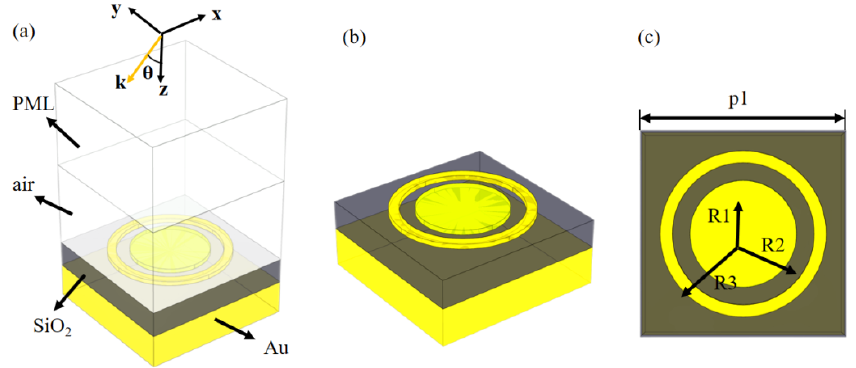
Figure 1. ( a ) Front view of absorber, ( b ) periodic unit of absorber, ( c ) top view of absorber. We implement the periodic array with a single structural unit by setting Floquet periodic boundary conditions. When the electromagnetic wave is incident perpendicular to the absorber surface, the electric and magnetic fields are parallel to the x and y axis directions respectively. The z-direction is set to perfectly match the layer, as shown in Figure 1a. In the simulation, all the metallic layers are composed of gold material. In the closed-loop disc structure and geometrical parameters we designed, the electromagnetic resonance of a specific frequency occurs when the electromagnetic wave interacts with ω 2 p the absorber. By means of the Drude model [35–37] ε = 1 − . We can calculate the ω ( iwt ) dielectric constant of gold, where the volume plasma frequency is ω p = 1.37 16 s − 1 and collision frequency ω t = 1.23 14 s − 1 [38]. When the thickness of the underlying metal is greater than the maximum skin depth of the metal in terahertz, spectrum the transmittance of the absorber T = 0. Therefore, the absorptance of the absorber can be simplified